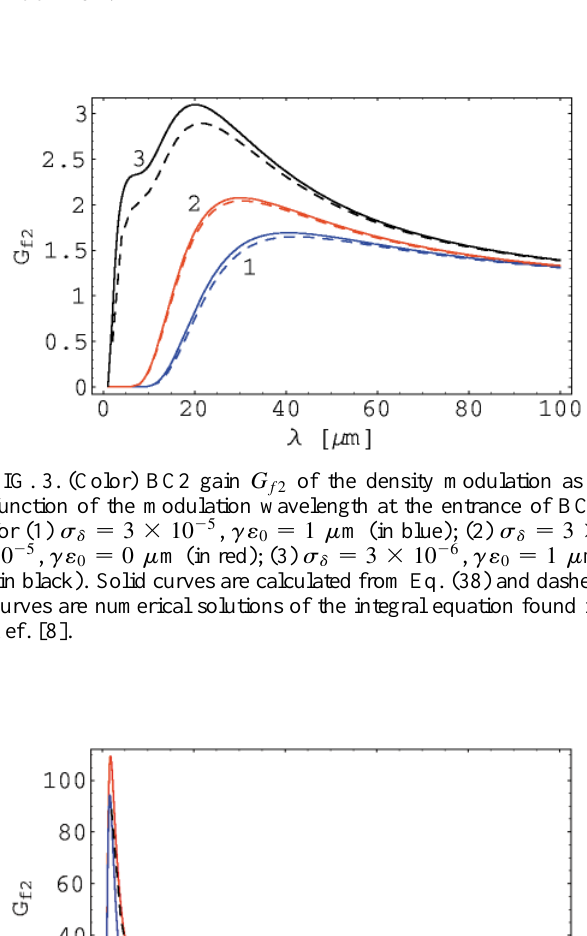
FIG. 2. Energy modulation amplitude j D p 1 (cid:1) k f ; f (cid:2) j (in units of initial bunching) as a function of modulation wavelength at the exit of BC1.